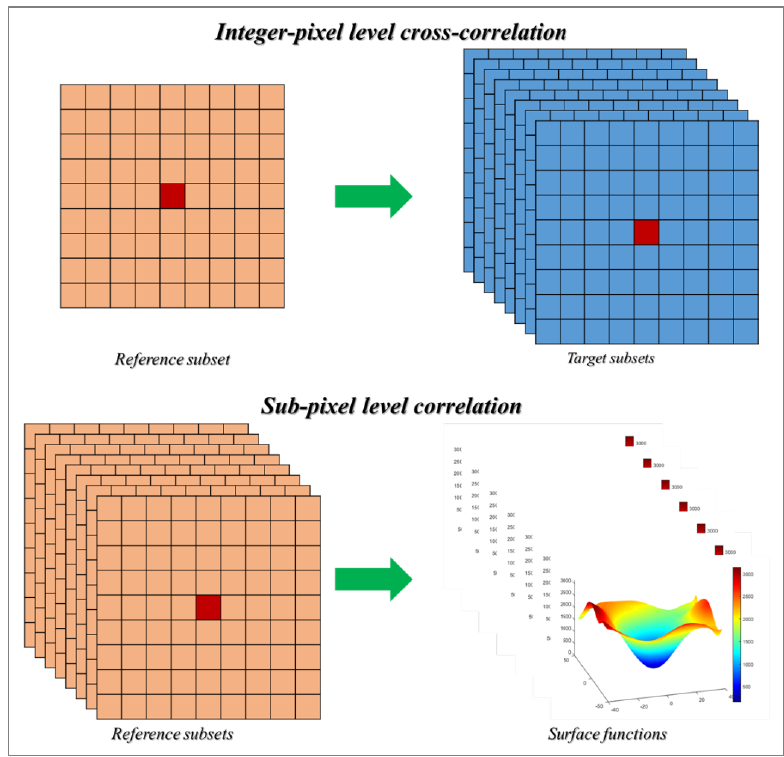
Figure 1. GPU parallel computing implementation of two stages of the height digital image correlation (hDIC) technique.